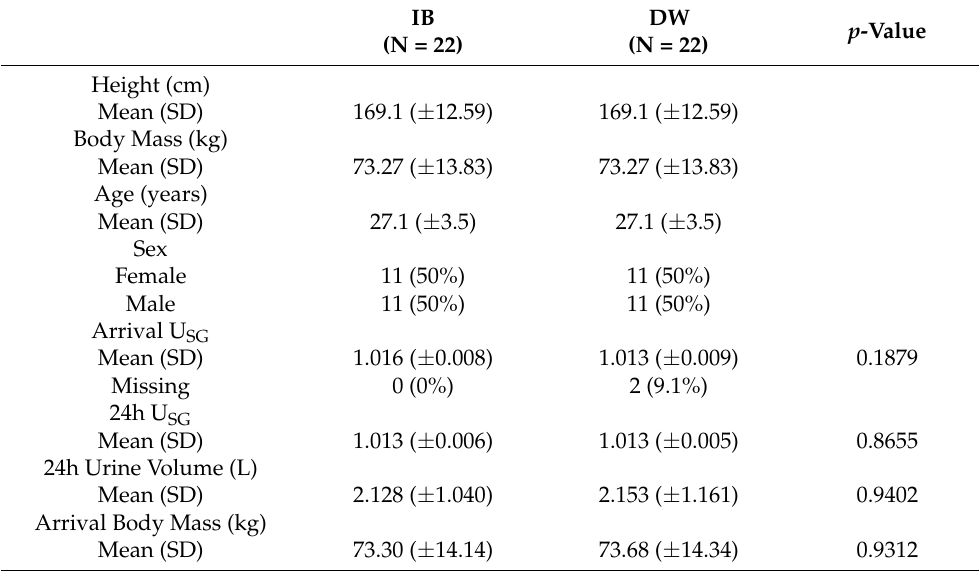
Table 1. Participant Demographic Characteristics. Values are presented as means ( ± SD).